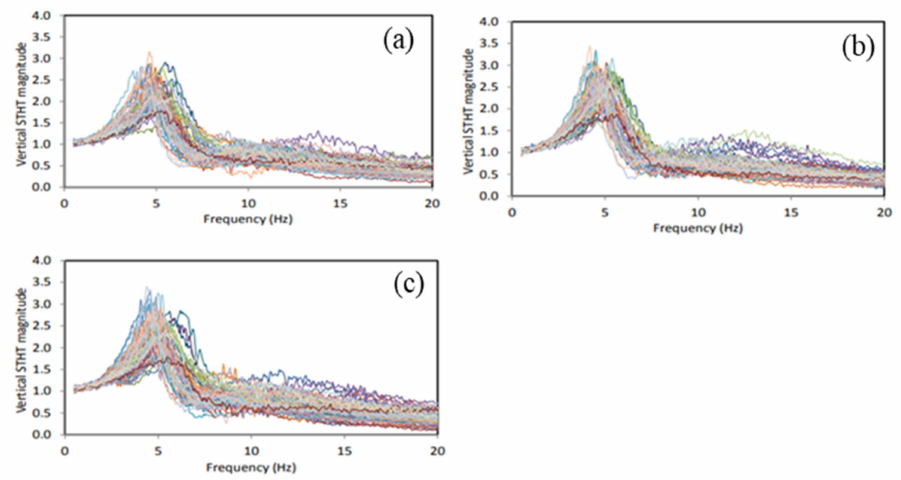
Figure 4. Vertical STHT magnitude responses of 58 participants seated without back support under 0.50 m/s 2 RMS excitation: ( a ) seat A; ( b ) seat B; and ( c ) seat C.